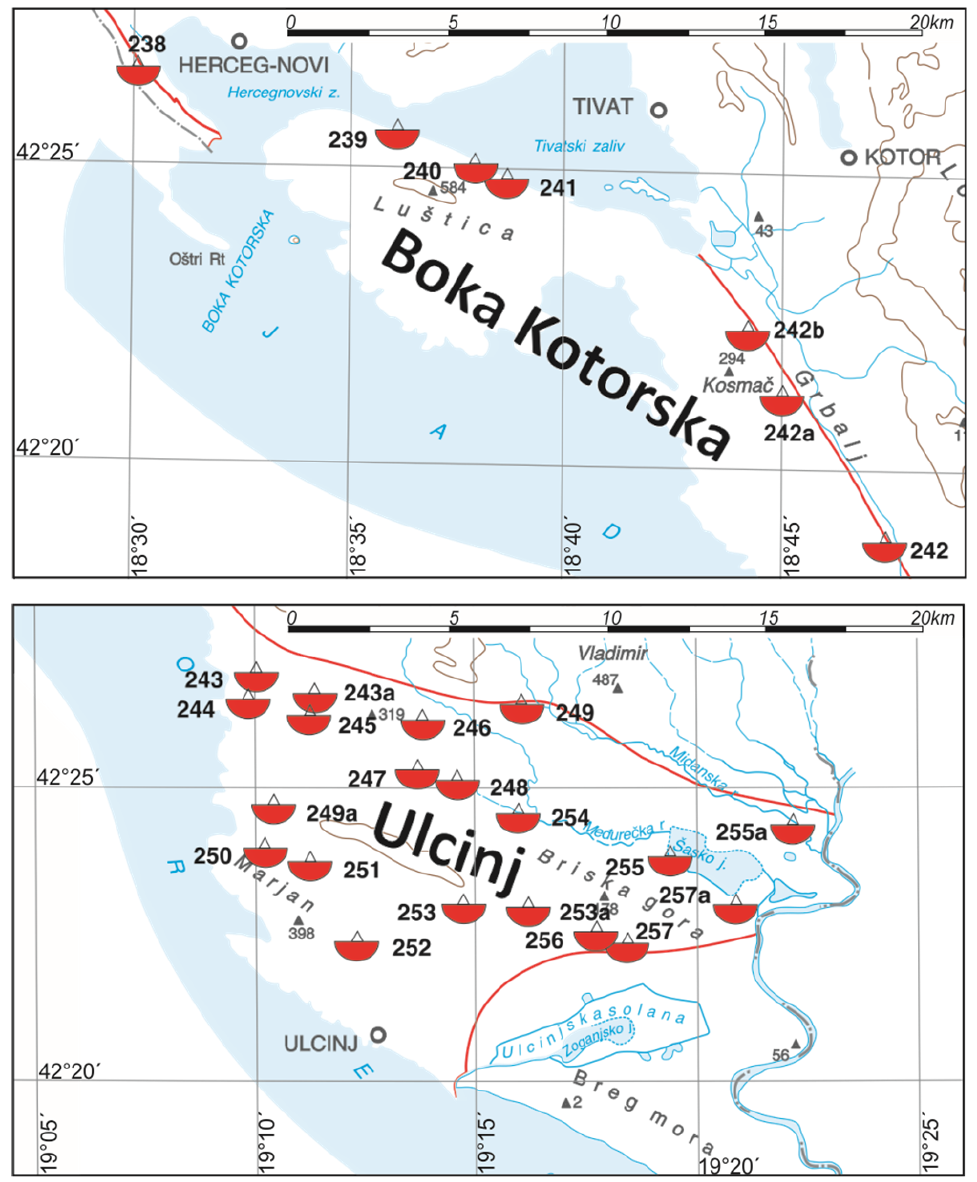
Figure 4. Occurrences of karstic bauxites of Boka Kotorska and Ulcinj bauxite-bearing regions (after Pajovi ć [15], modified).